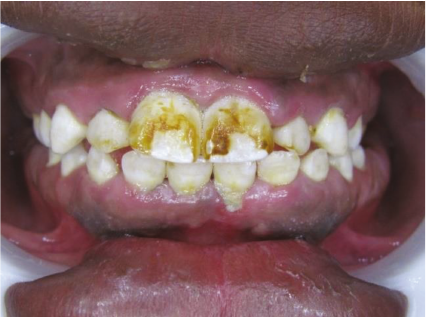
Figure 13: Case 3: small size of teeth which may be due to gingival enlargement or incomplete eruption (right side view).